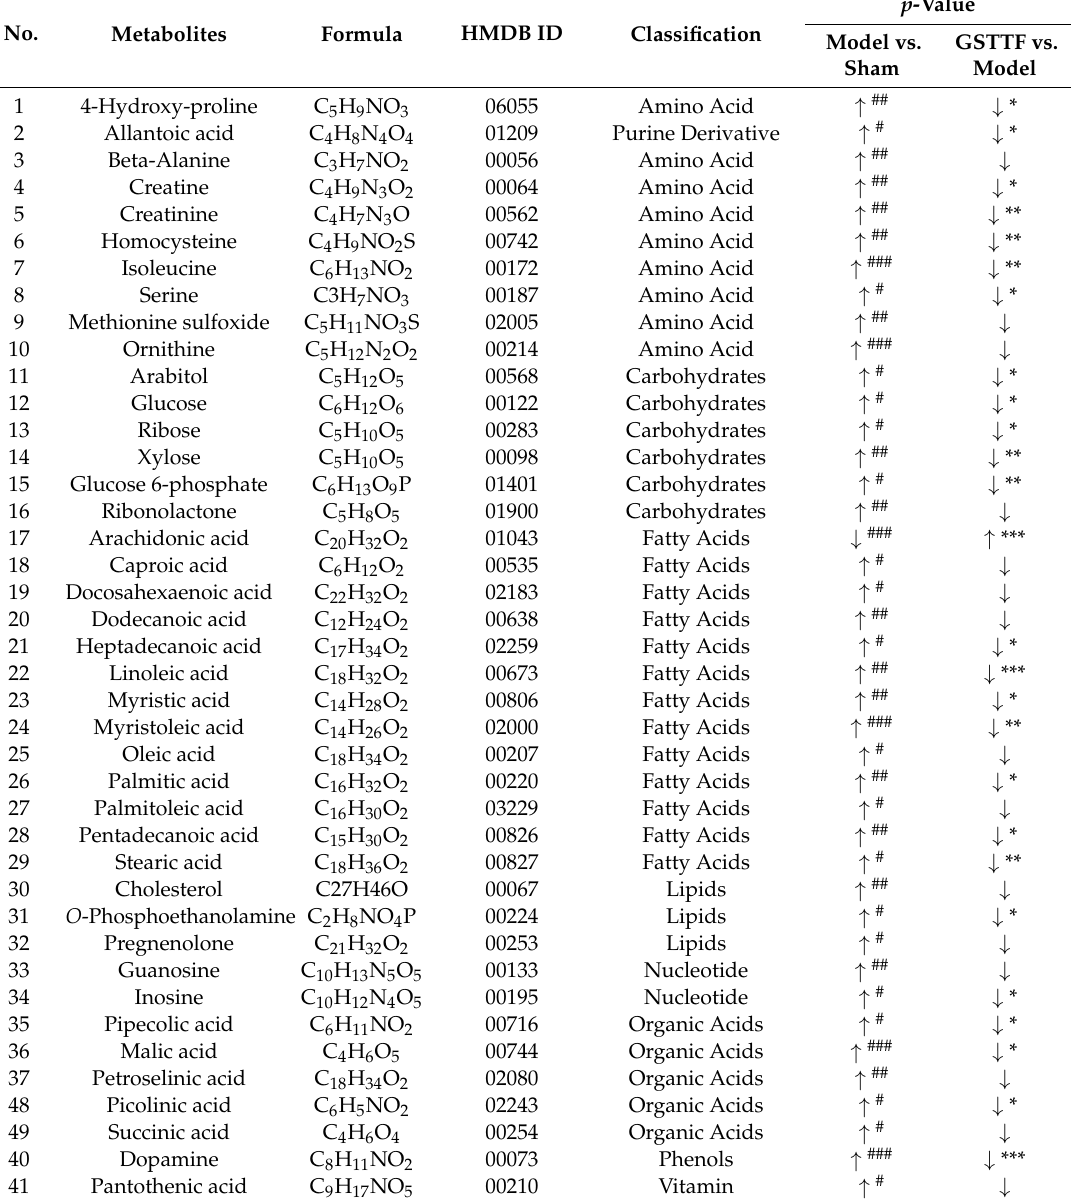
Table 1. Identified endogenous metabolites and their change trends in